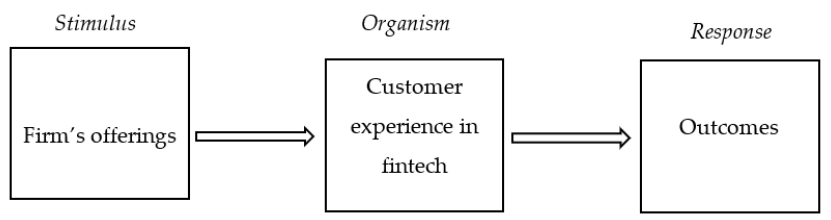
Figure 1. Determinants and consequences of customer experience in fintech. Source: Adapted from Becker and Jaakkola, 2020, p.638.